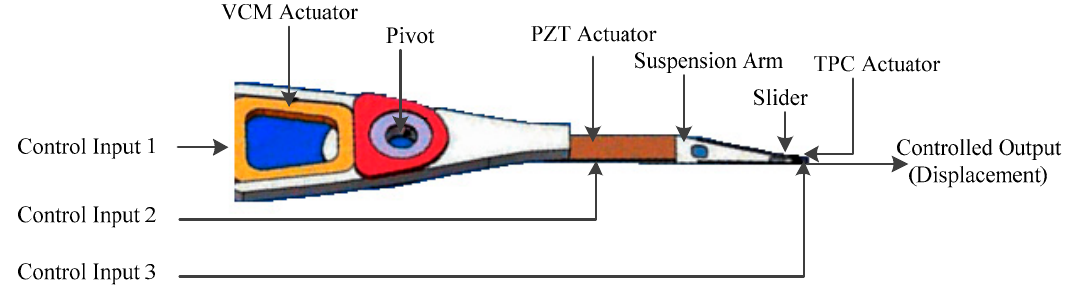
Figure 3. Triple-stage actuation system.